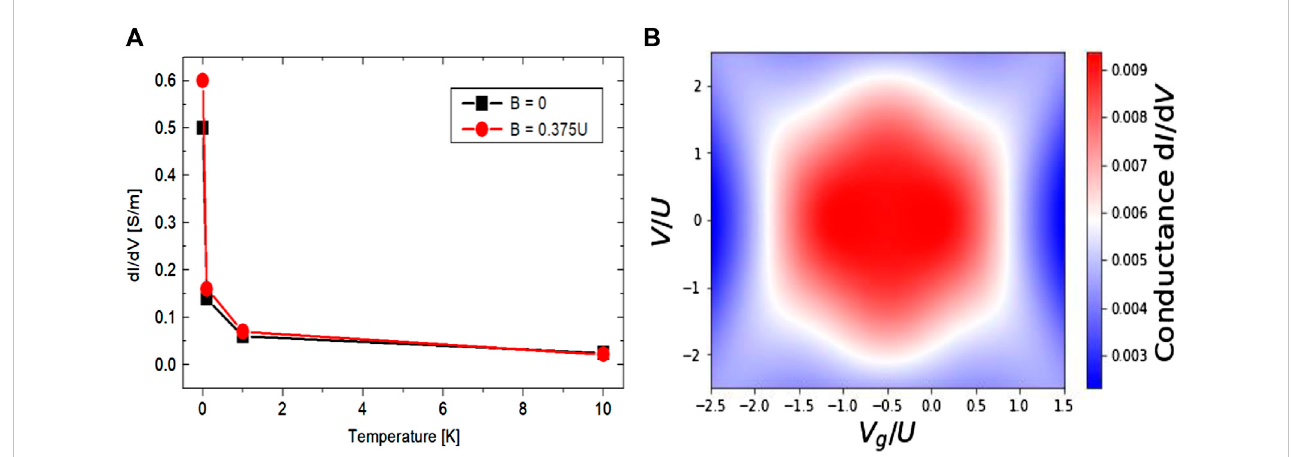
FIGURE 8 Summary of the changes in conductance with temperature with magnetic fi eld (A) . Zeeman spin-splitting magnetic- fi eld independent conductance of the quantum dot at 40 K (B)